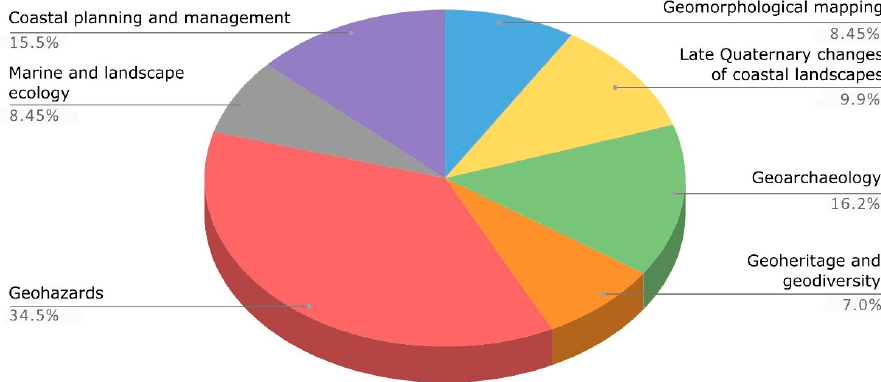
Figure 2. Thematic distribution of the main scientific literature referring to the integration of terrestrial and marine datasets according to the fields of application shown in Table 1. and marine datasets according to the fields of application shown in Table